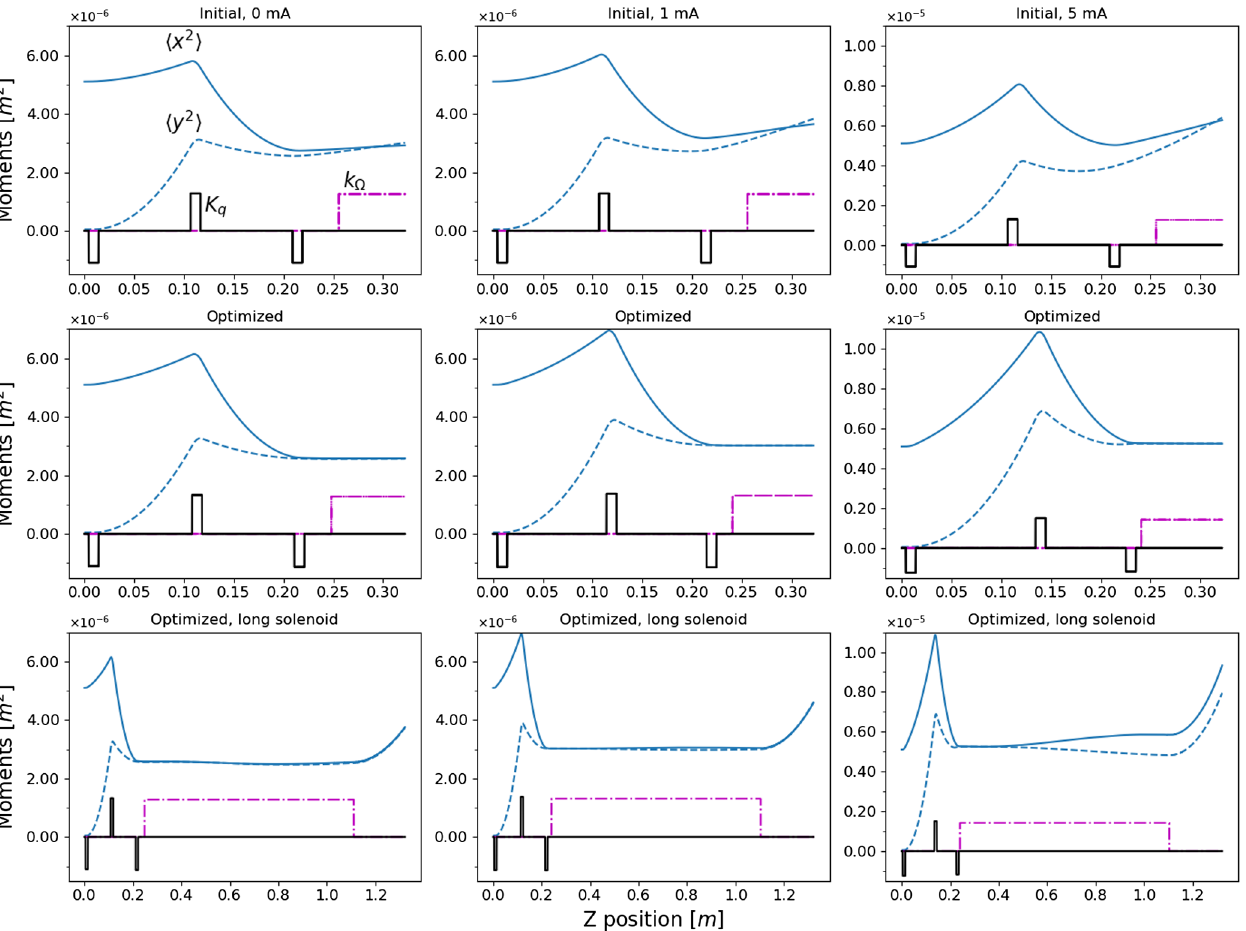
FIG. 4. rms beam size, h x 2 i ; h y 2 i , plotted as a function of the longitudinal coordinate through an FTR transformer. The top row shows the initial results with no optimization. The middle row shows the optimized results. The bottom row shows the same optimized results as the middle row, but integrates the beam motion through a much longer solenoid (z position). Scaled quadrupole ( K q ) and solenoid ( k Ω ) field profiles are also displayed for reference. Results are for a 5 keV